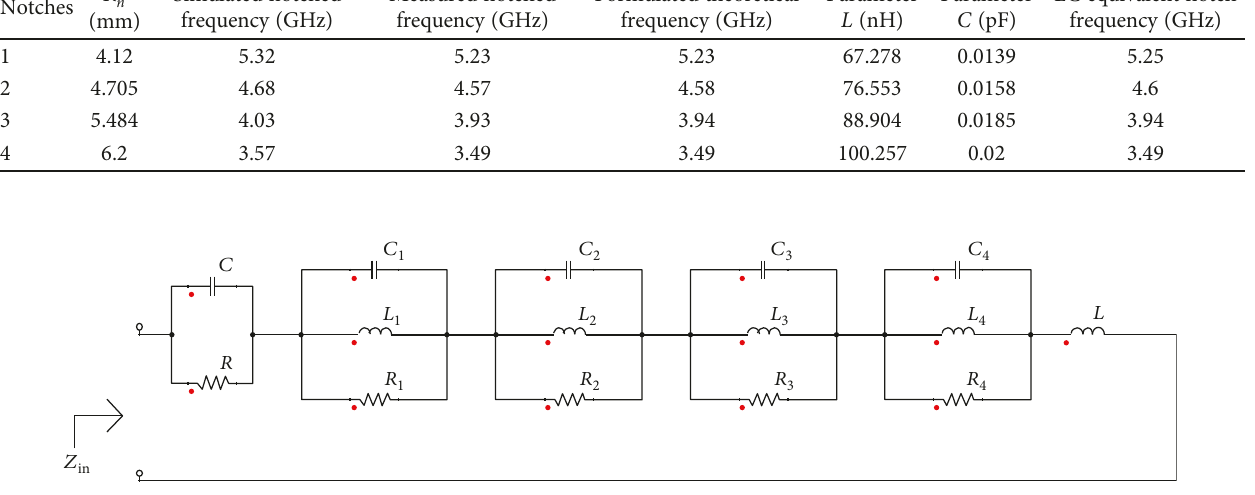
Table 2: Comparison of LC equivalent lumped element with simulated, measured, and formulated notch frequency. Notches